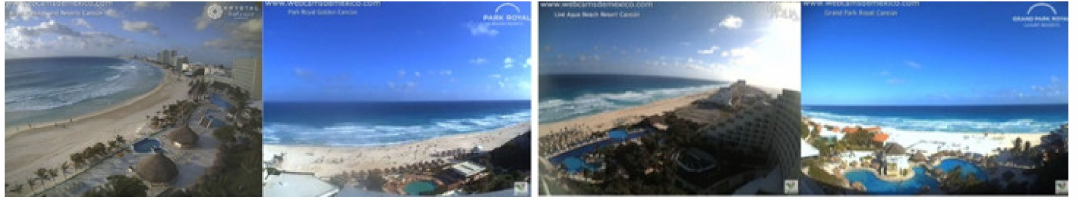
Figure 15. Recent views of the beach at Cancun, January 16, 2020